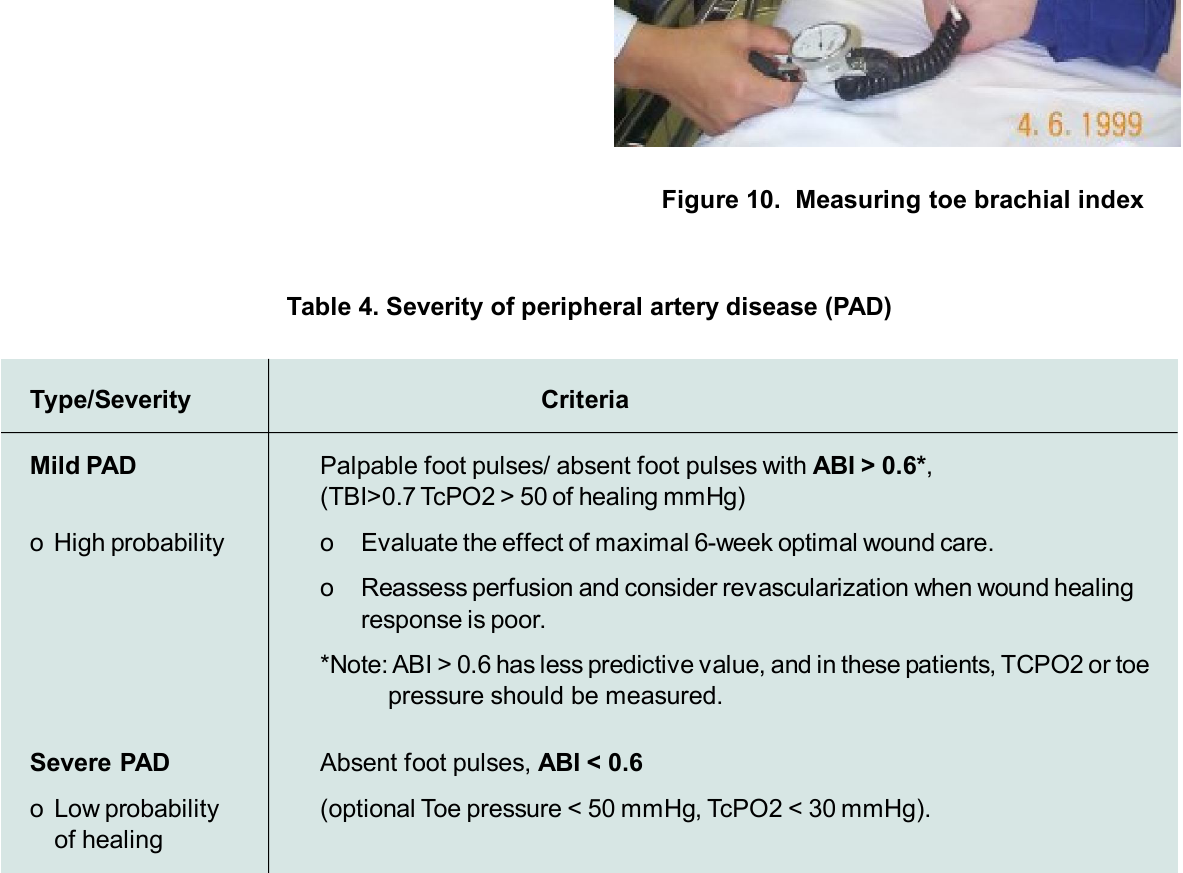
Toe Brachial Index (TBI) when ABI is high (>0.9) Figure 10 o 40% of all diabetic patients with an ulcer present falsely high ABI values (ABI>1.3)